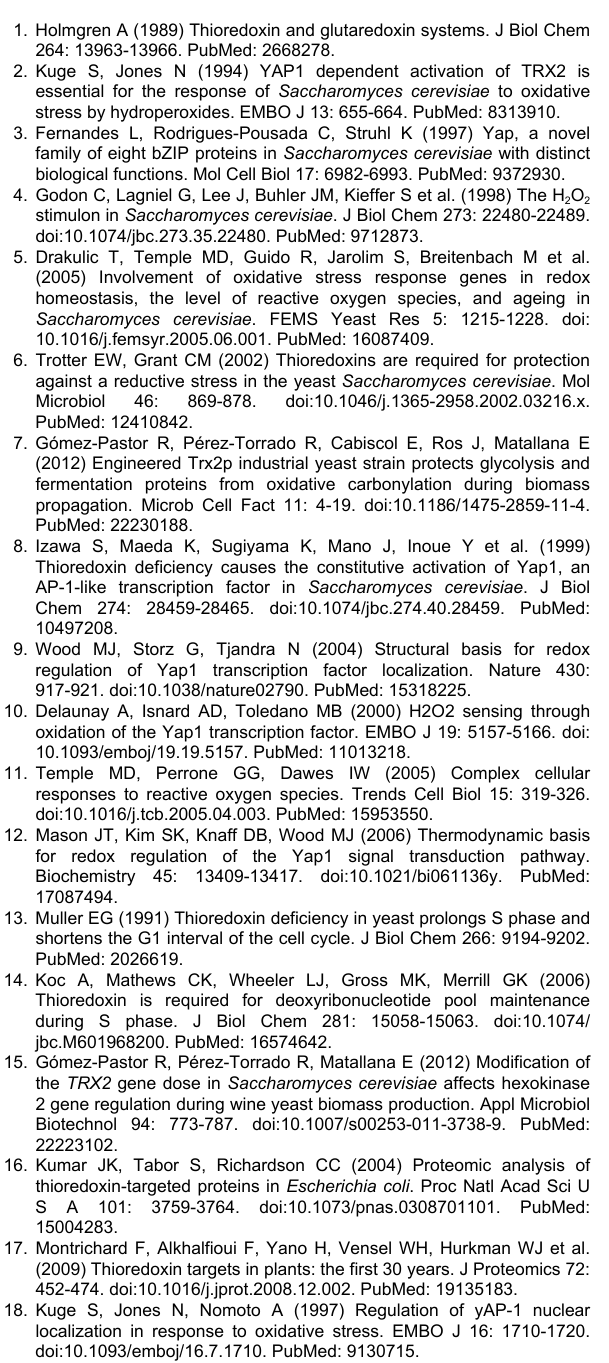
Table S1. Genes and primers used for the amplification of DNA